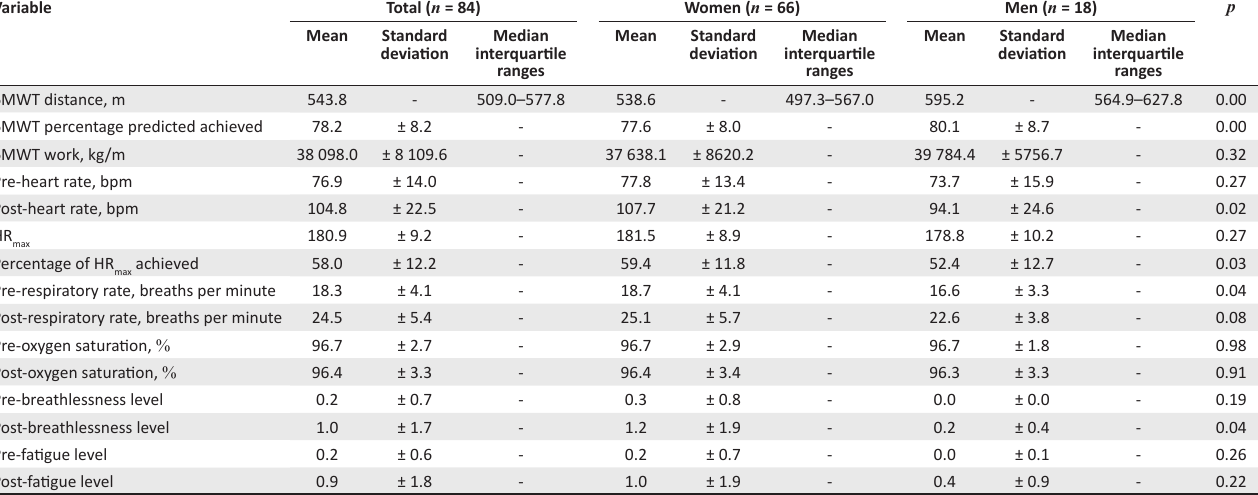
TABLE 2: The 6-min walk test findings of study participants ( n = 84). Variable Total ( n = 84) Women ( n = 66) Men ( n = 18)